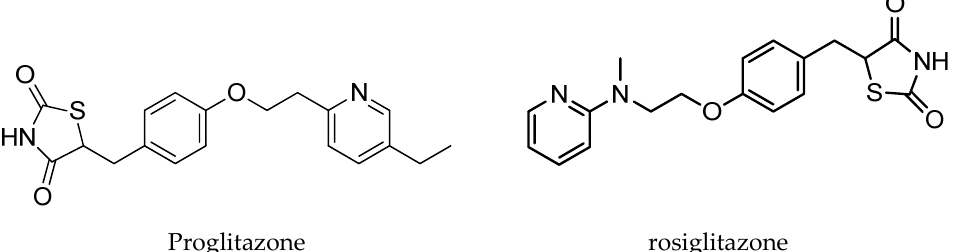
Figure 2. Approved drugs with thiazolidinone